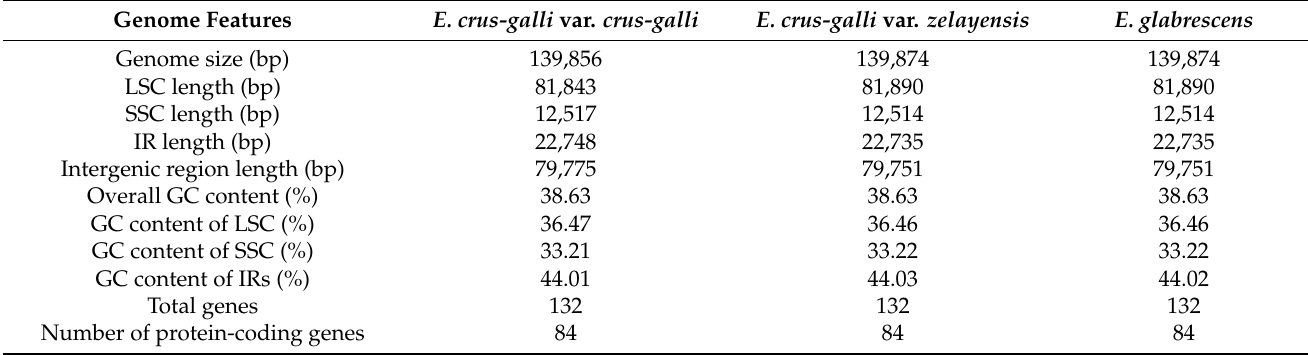
Figure 3. Assembly, size, and features of cp genomes of three Echinochloa spp. The genes outside the circle are transcribed in the counterclockwise direction, and the genes inside the circle are transcribed in the clockwise direction. Different colors in genes represent different functions. The dark gray area and light gray area of the inner circle represent the GC content to AT content of the genome, respectively. Table 2. Summary of chloroplast genome features in three barnyard grass biotypes.